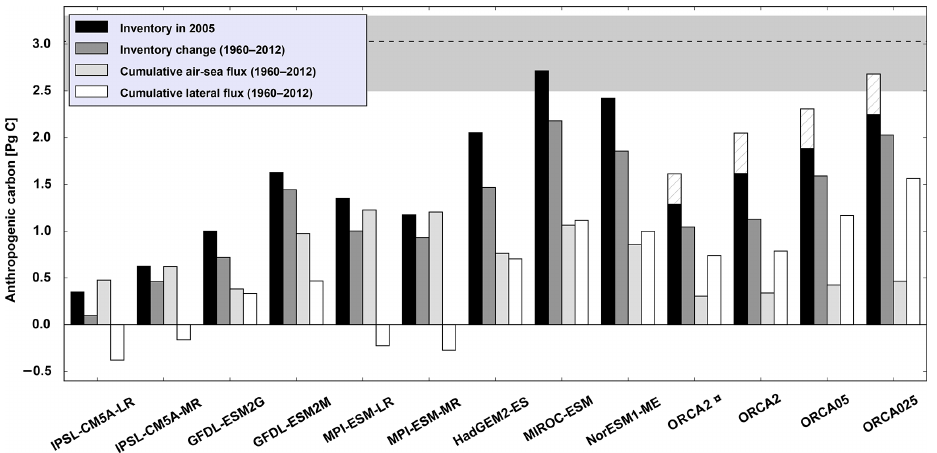
Figure 9. Comparison of results for the Arctic Ocean from ORCA2, ORCA05, ORCA025, and ORCA2 ∗ and the nine earth system models that participated in CMIP5. Shown are the C ant inventory in 2005 (black), the inventory change of C ant (dark grey) between 1960 and 2012, the corresponding cumulative air–sea flux of C ant (light grey), and the cumulative lateral flux of C ant (white). Also indicated are the data- based estimate from Tanhua et al. (2009) (dashed black line) along with its associated uncertainty range (grey background). The inventory correction for the late starting date for our forced simulations is indicated as striped